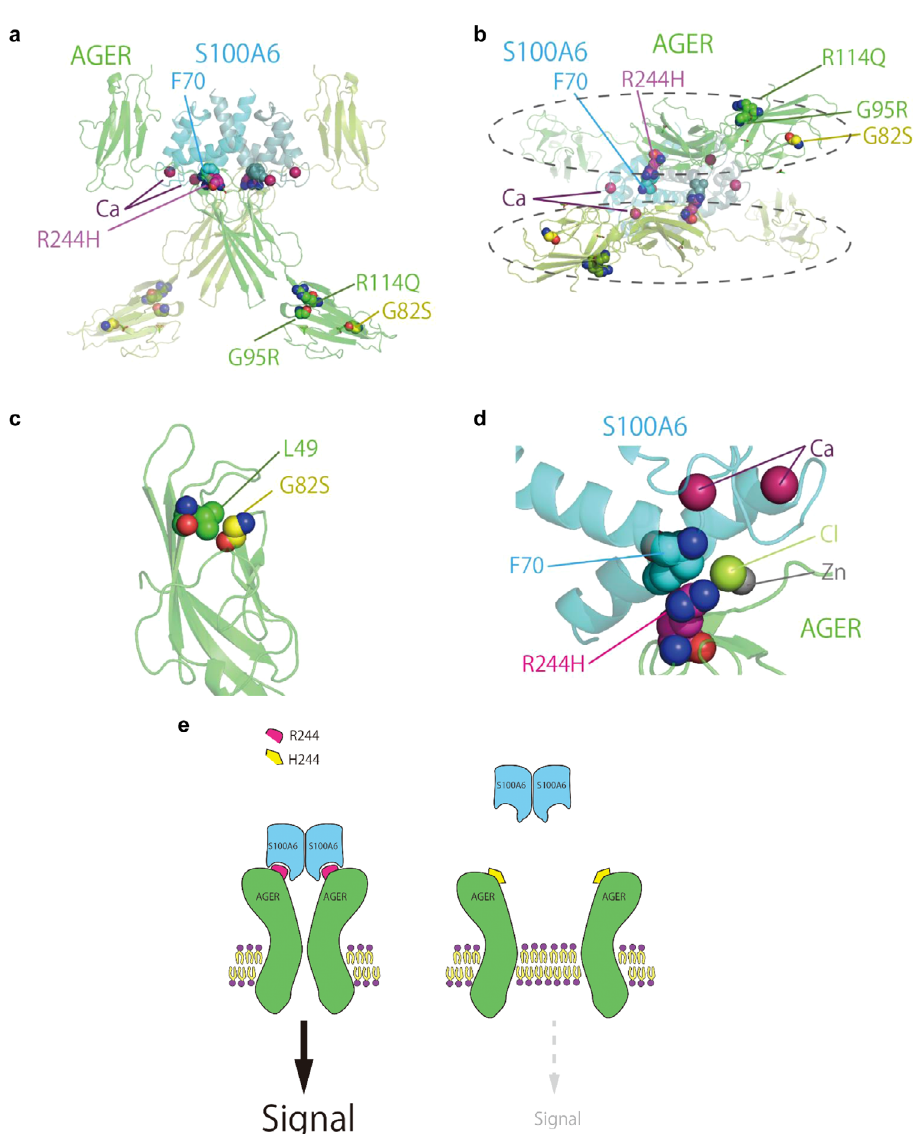
Fig. 5 The presumable effects of missense variants of AGER suggested by the analysis of three-dimensional structure. a Side view of the AGER (light and dark green) and S100A6 (light and dark cyan) heterotetramer. b The same tetramer as in ( a ), viewed from the axis of symmetry. The dashed ellipses show two AGER domains, which are not in direct contact with each other. c Close up view of the G82 (yellow) and L49 (green) of AGER. d Close up view of the AGER R244 (magenta) and S100A6 F70 (cyan) residues. e The explanatory scheme of the effect of the R244H substitution on the signalling of AGER. The R244H substitution can impair the interaction between a AGER and a S100A6 because two AGER subunits are in indirect contact with each other via the S100A6 dimer, which results in the inhibition of the dimerization and signalling of the